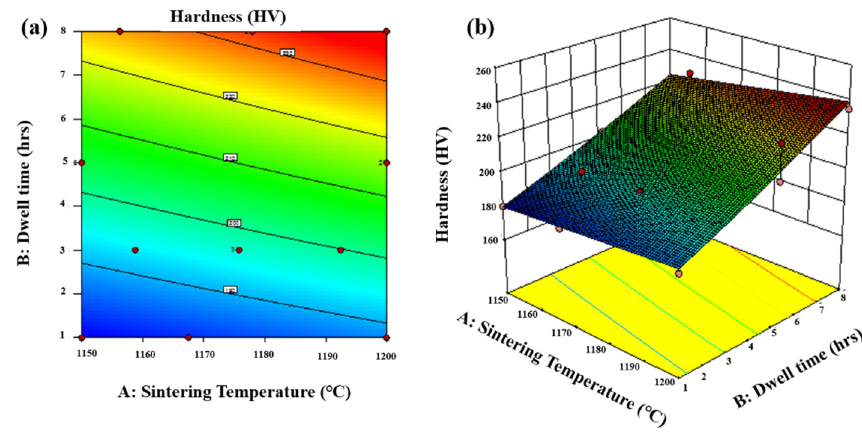
Figure 17. Contour and 3D plots of microhardness. (a)**; (b)**.